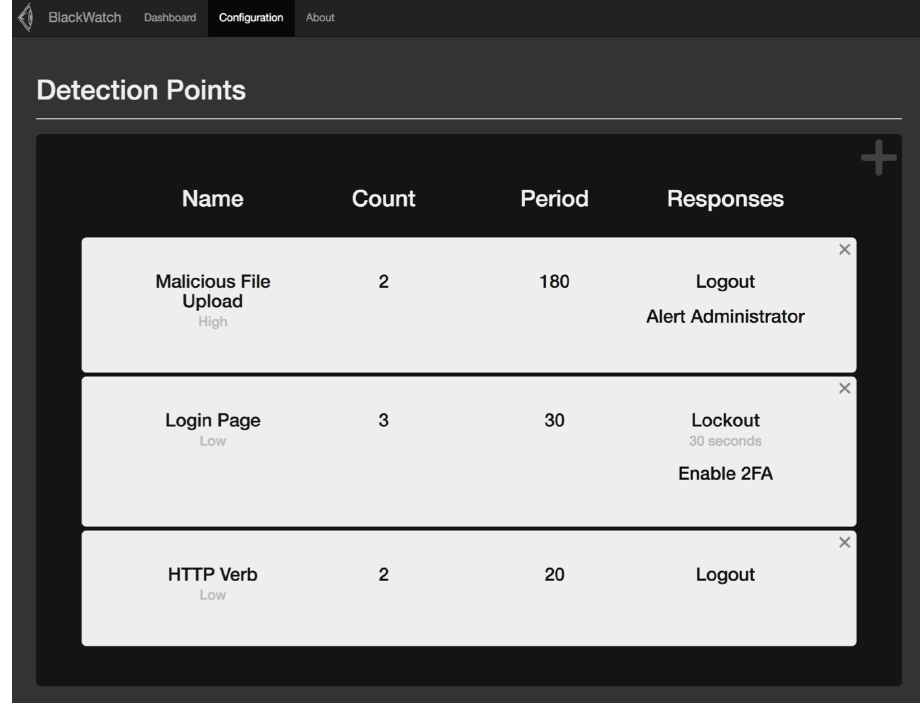
Figure 9. Configured detection points interface in